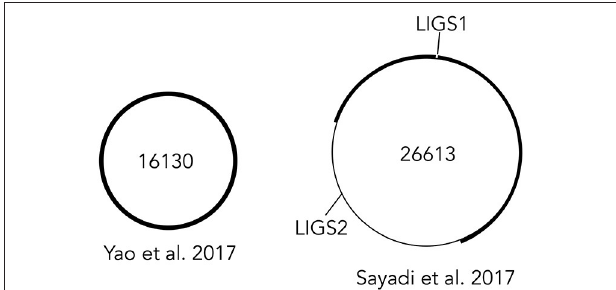
FIGURE 1 | Two schematic mtDNA of Acanthoscelides obtectus with different lengths. There are short (1) and long (2) long intergenic spacers (LIGS1 and LIGS2) in the longer one. Other than the spacers, two mtDNAs are identical.